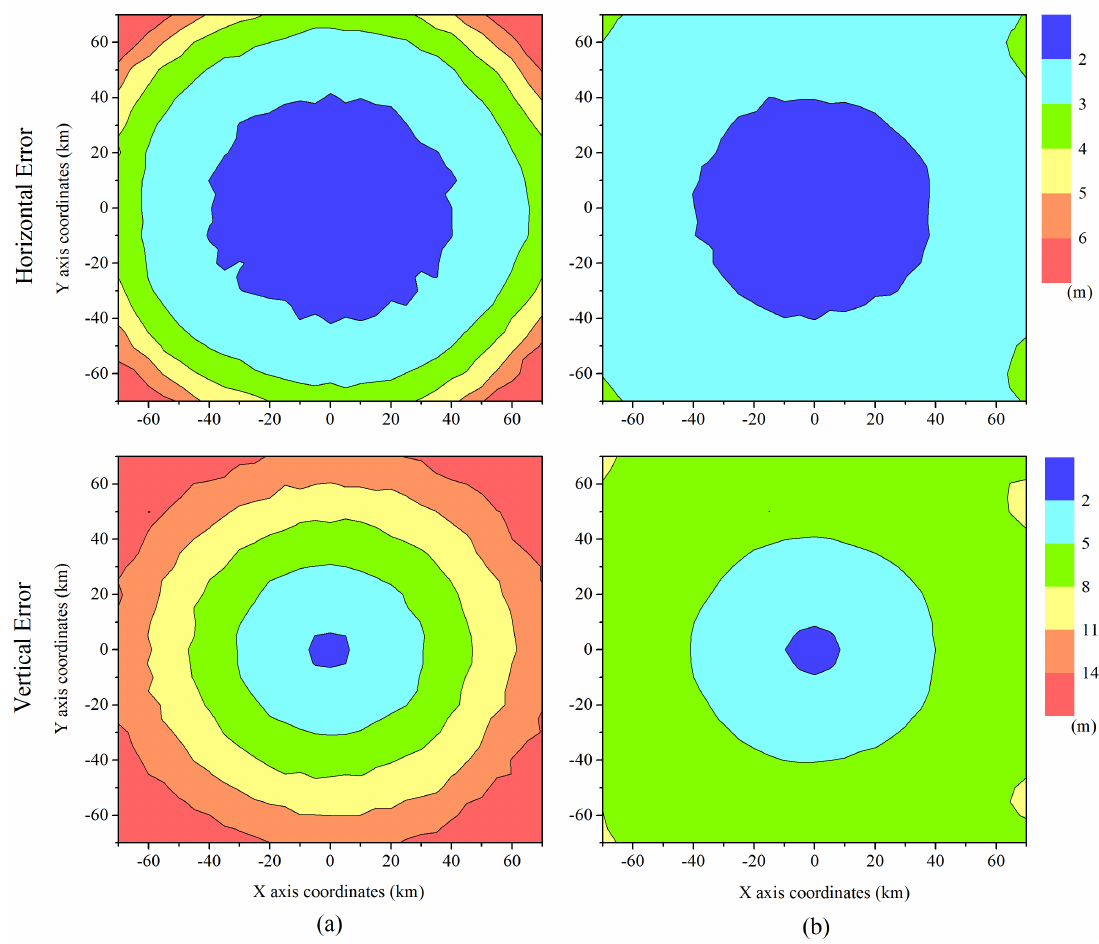
Figure 7. Horizontal and vertical accuracies of the user in a service area. ( a ) Existing algorithm; ( b ) Enhanced